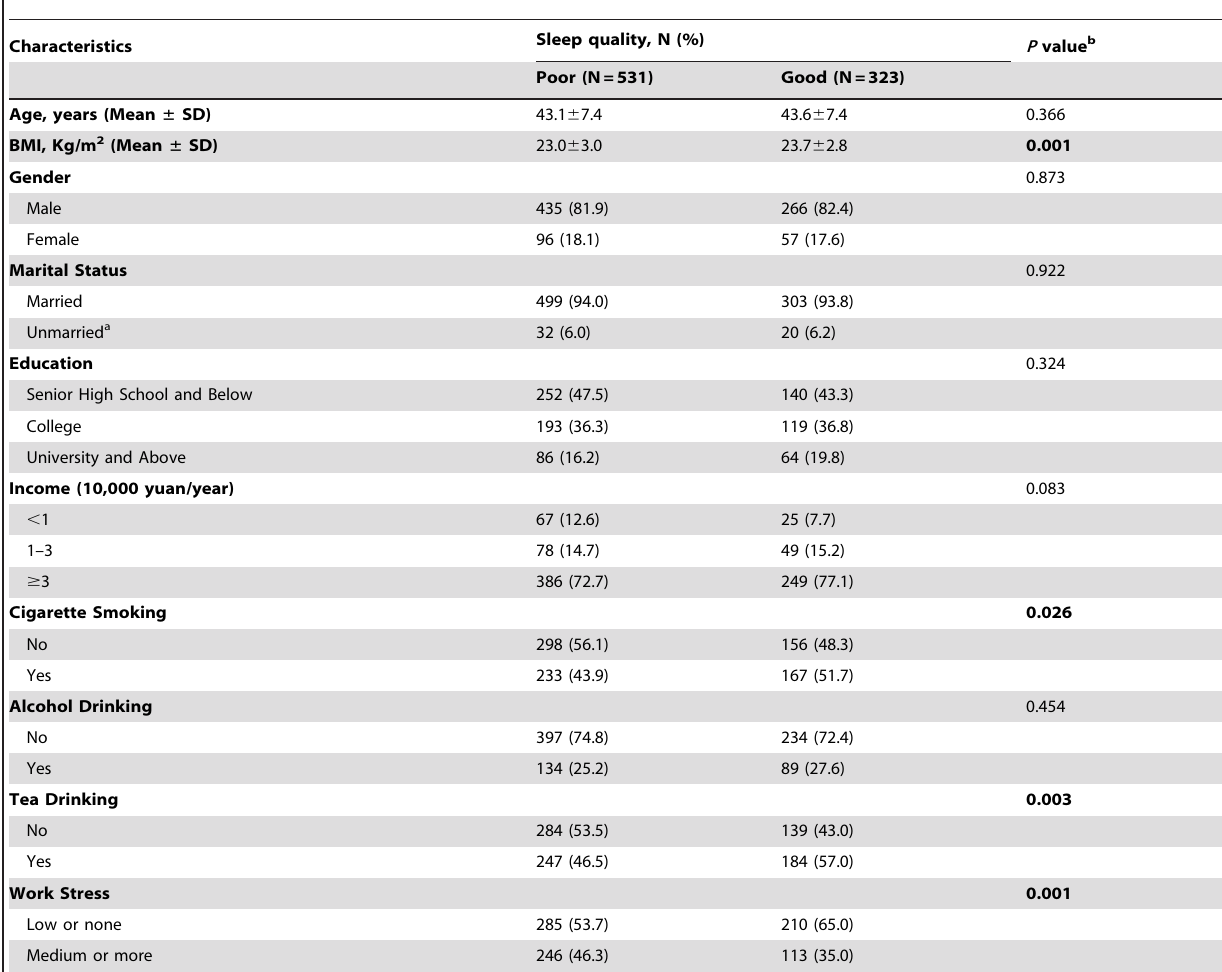
Table 1. Demographic characteristics of study subjects stratified by sleep